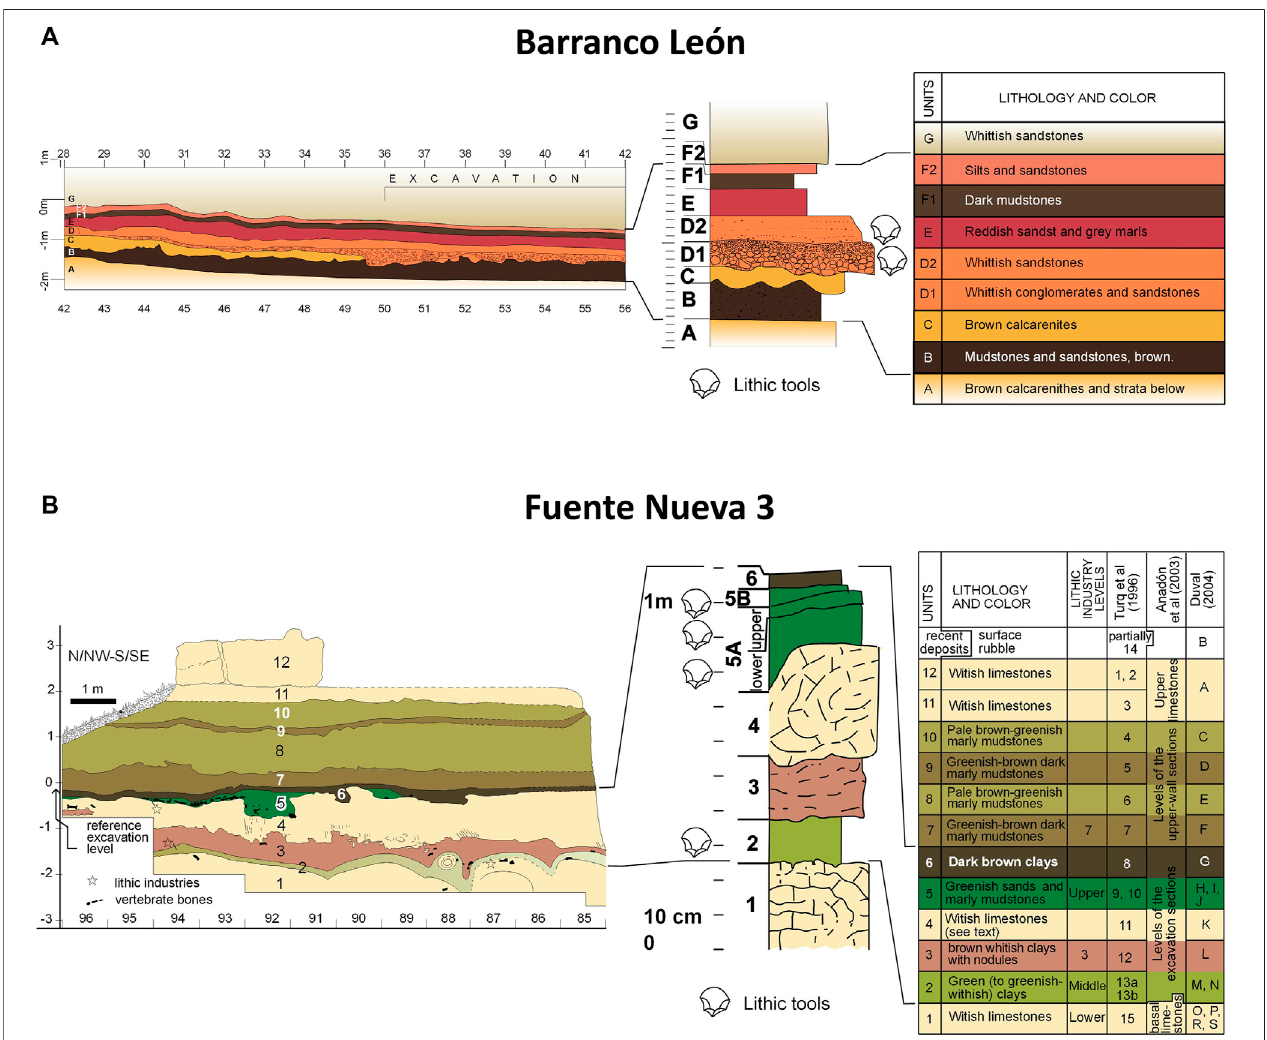
FIGURE3|(A) Stratigraphicsectionandmainsedimentologicalfeatures oftheBarrancoLeónsite. (B) Stratigraphicsectionandmainsedimentological featuresof the Fuente Nueva 3 site (Figures re-drawn by O. Oms after Oms et al., 2011 and Sánchez-Bandera et al., 2020).